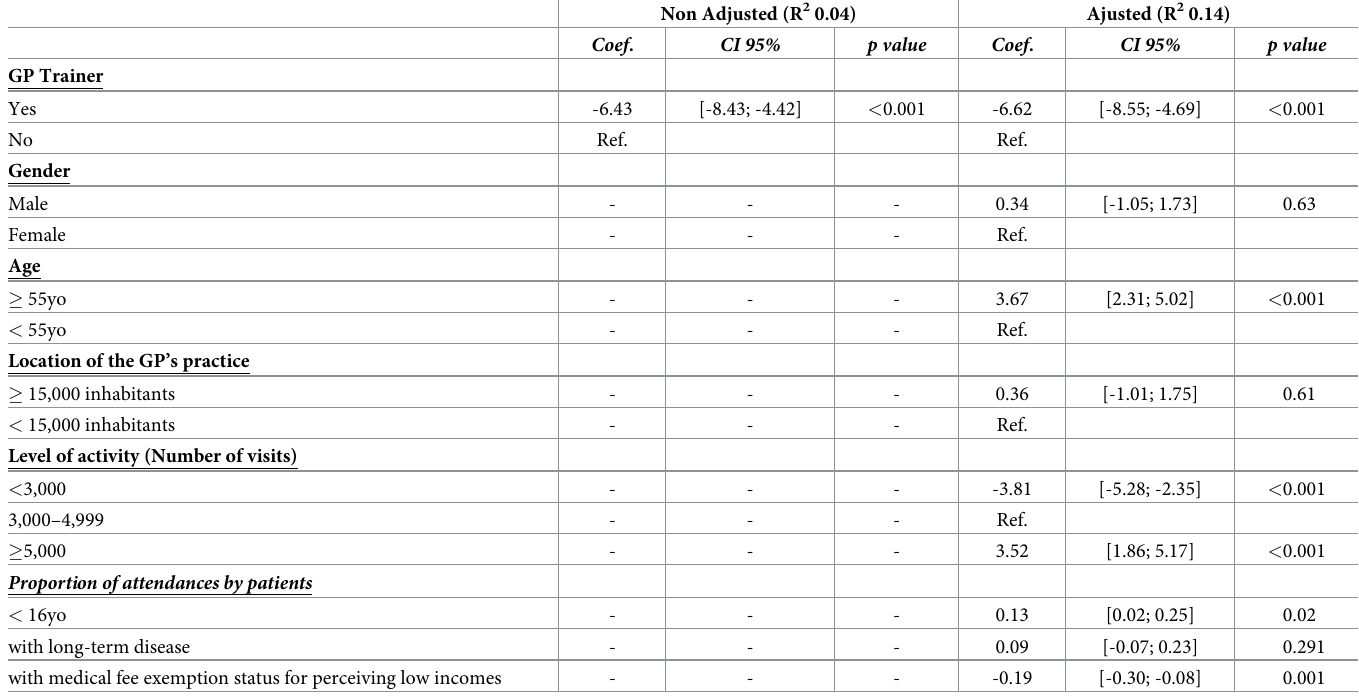
Table 3. Results of the multivariate regression